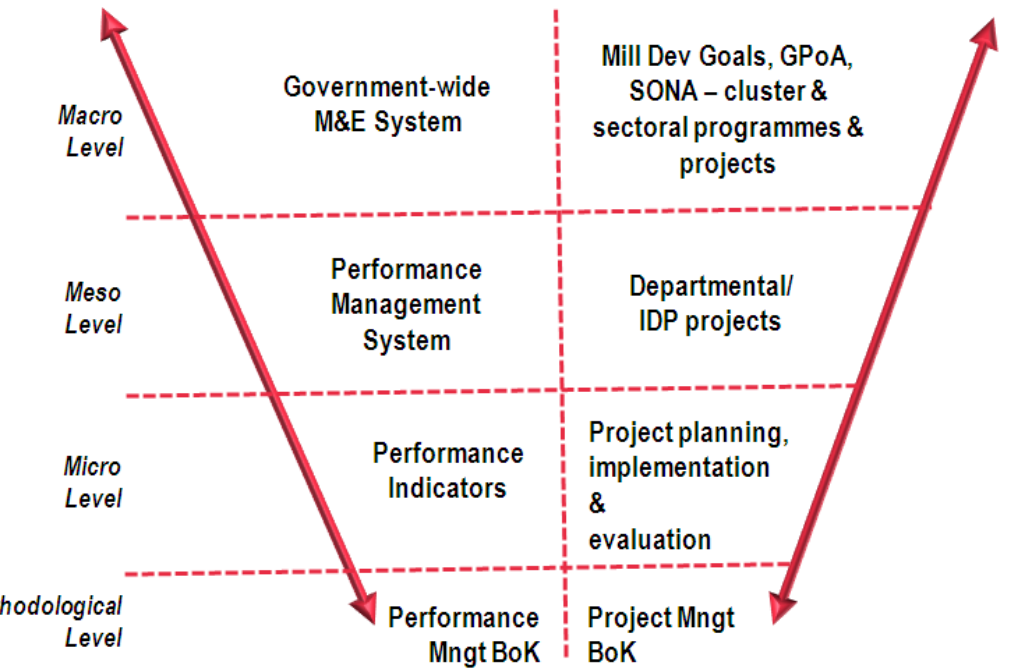
Performance Management and Project Management matrix: The